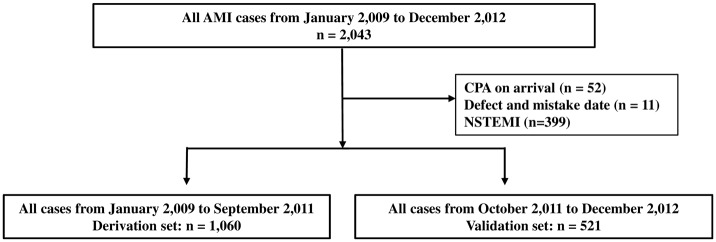
Study protocol and flow chart.AMI, acute myocardial infarction; CPA, cardiopulmonary arrest; NSTEMI, non ST-elevated myocardial infarction.